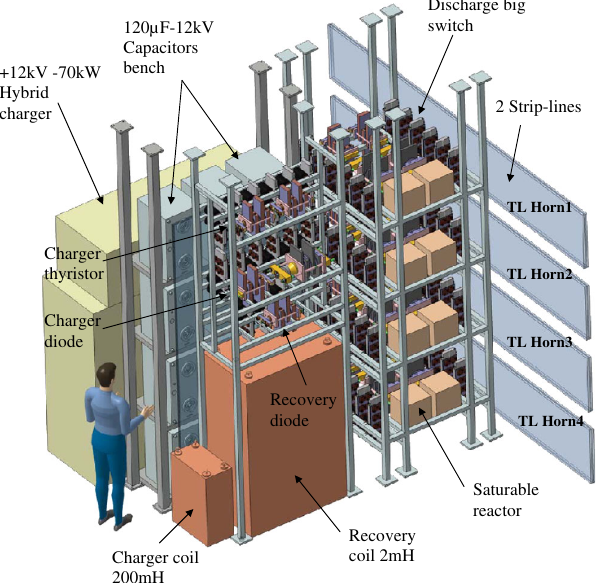
FIG. 24. Artist ’ s view of a power supply